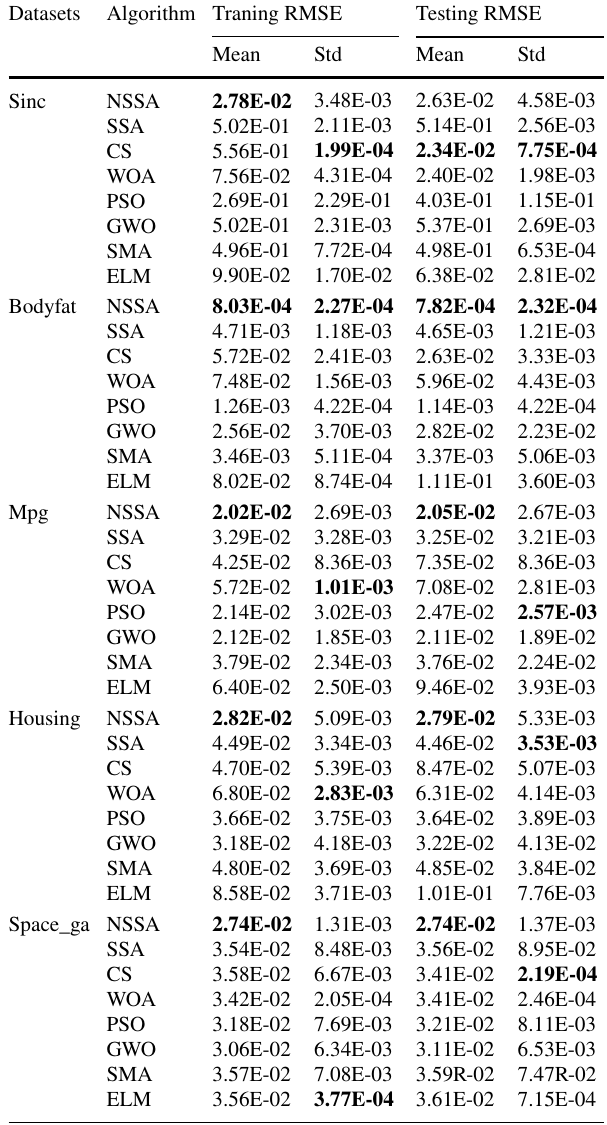
Table 5 Comparison of mean value of regression data set and STD